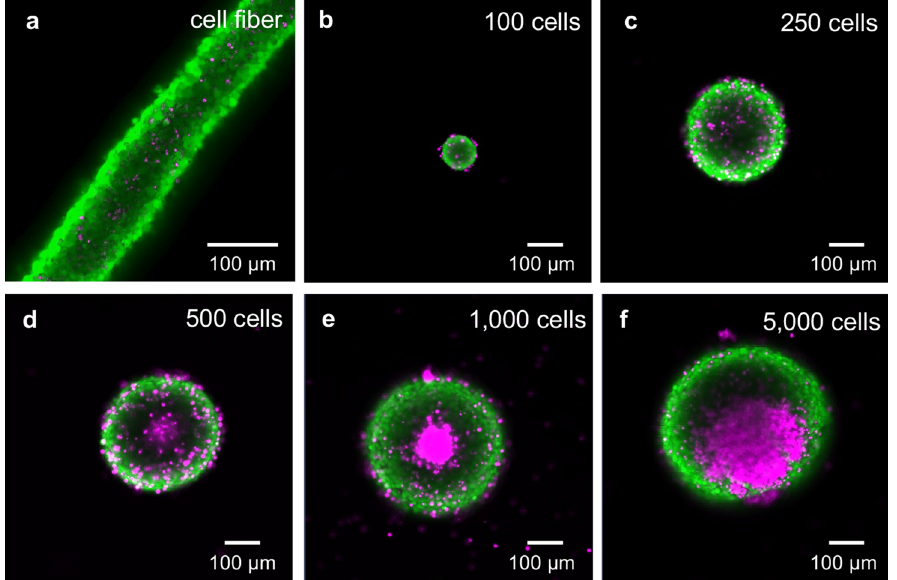
Figure 3. Live/dead cell viability assay of GT1-7 CF fragment and GT1-7 spheroids. GT1-7 CF fragments and GT1-7 spheroids fabricated with different initial cell numbers (100, 250, 500, 1000, and 5000 cells) were cultured for 11 days. The cells were stained with the live/dead cell staining kit II. ( a ) Fluorescence image of live/dead assay of GT1-7 CF fragment. ( b )–( f ) Fluorescence images of live/dead assay of GT1-7 spheroids fabricated with different initial cell numbers (100, 250, 500, 1000, and 5000 cells). The live and dead cells exhibited green and magenta fluorescence, respectively.